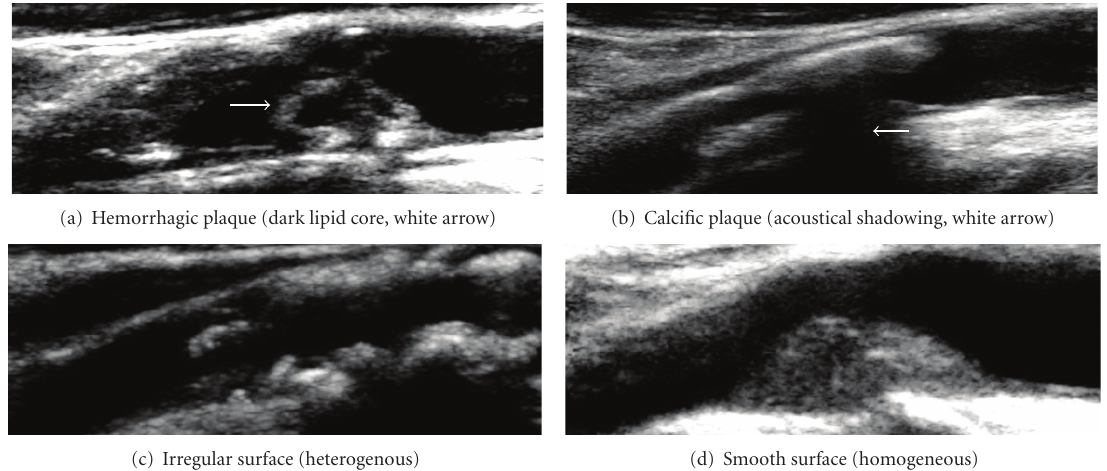
Figure 1: CDU and plaque morphology (structure and surface characteristics).